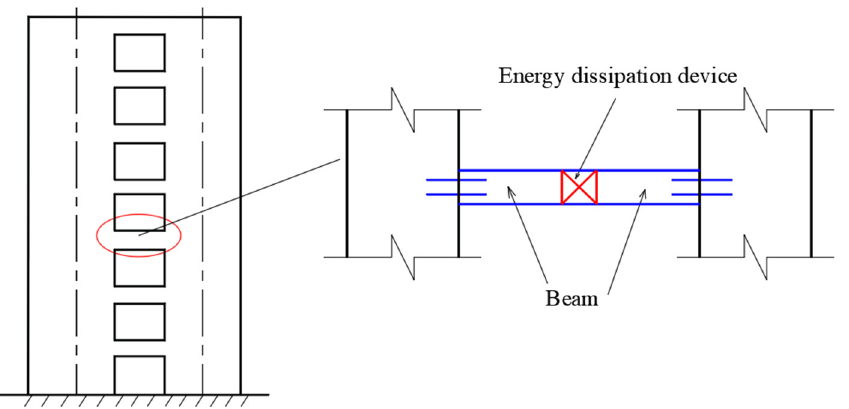
Figure 3. Structural model of the coupling beam with an energy dissipation device.